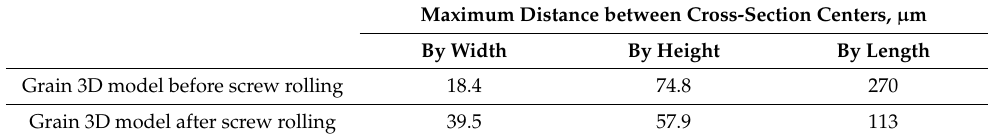
Table 2. Maximum distances between cross-sections of the grain models before and after three-high screw